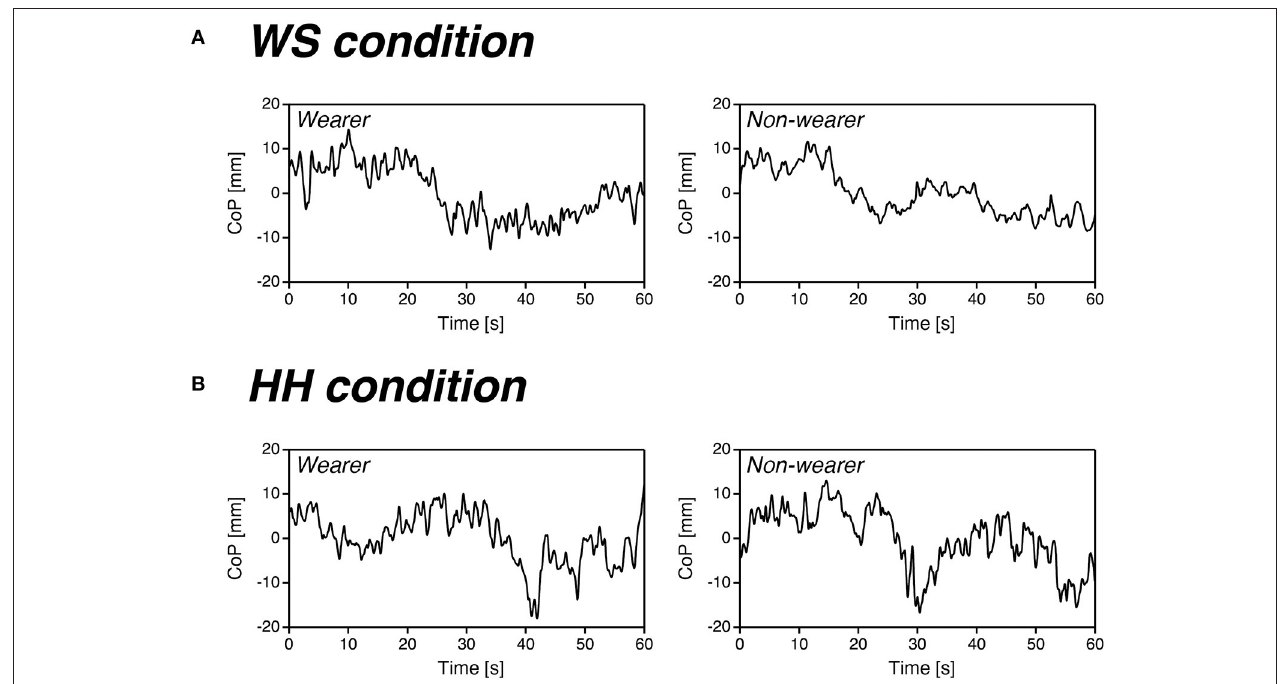
FIGURE 2 | Representative recordings of the CoP sway for one high-heel wearer ( left ) and one non-wearer ( right ) in the WS (A) and HH (B) conditions. (A) Overall excursion of the CoP showed no difference between the two participants, whereas fast ripples were more prominent in the CoP recordings for the wearer. (B) Fast ripples were observed in the recordings for both the wearer and non-wearer, and no apparent differences were observed between the two